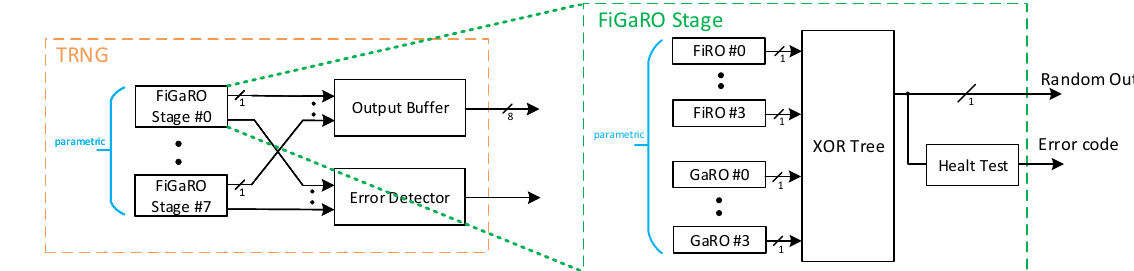
Figure 16. Overall architecture of the implemented FiGaRO Random Number Generator